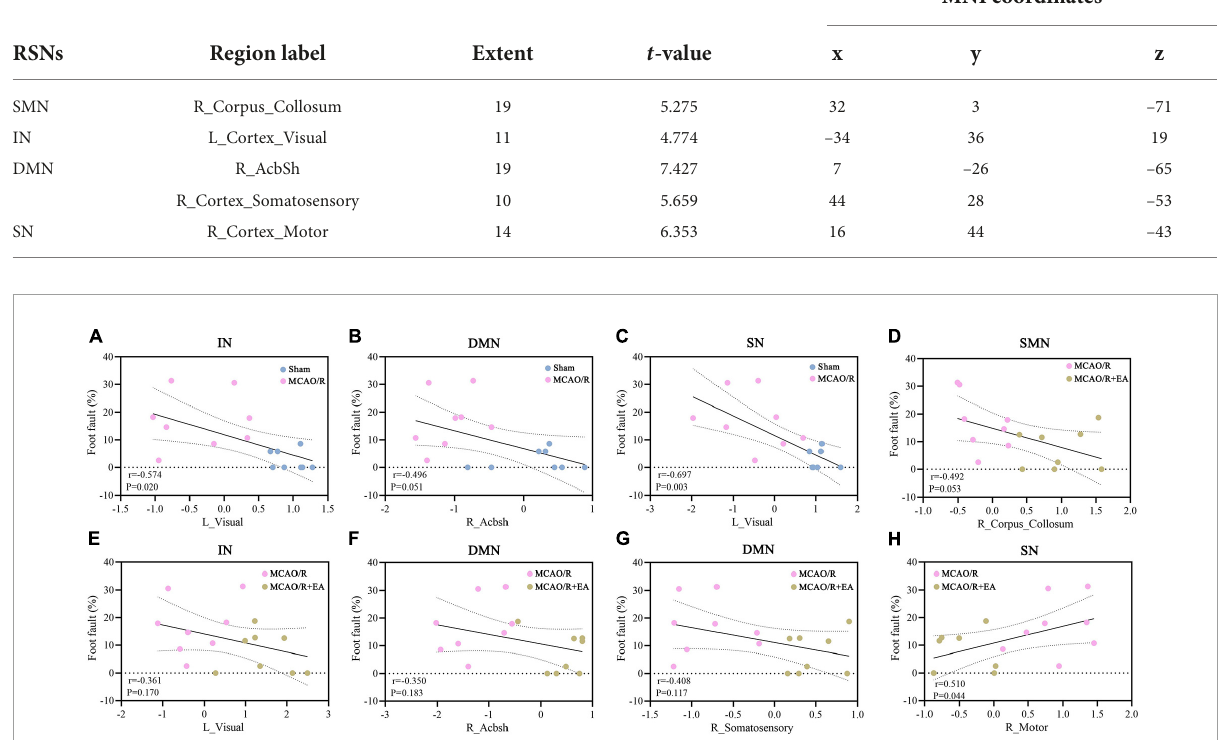
TABLE 2 Differences between MCAO/R and MCAO/R + EA groups in resting state functional connectivity of networks.